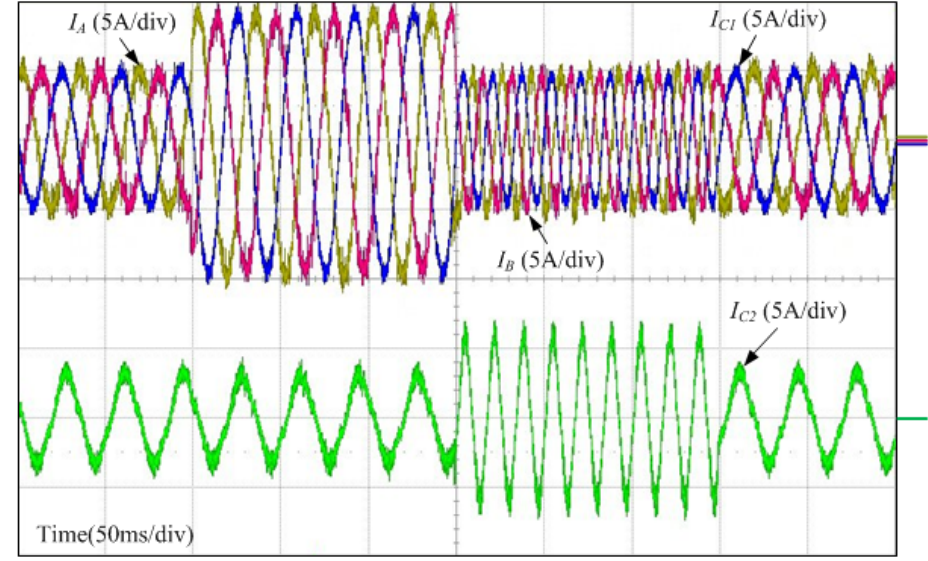
Figure 18. Experimental waveforms of the three-phase and single-phase output currents, controlled by the independent